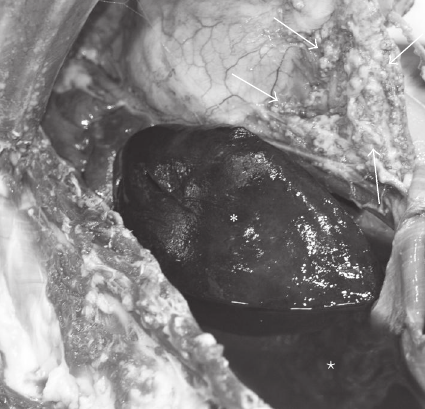
Figure 2: Gross photograph of the right thoracic cavity of a 15-year- old cheetah ( Acinonyx jubatus ). There is engorgement of the torsed right middle lung lobe (asterisk), and serosanguineous fluid par- tially fills the chest cavity (star). Multifocal coalescing tan nodules (mesothelioma) are present on the pleural and mediastinal surface